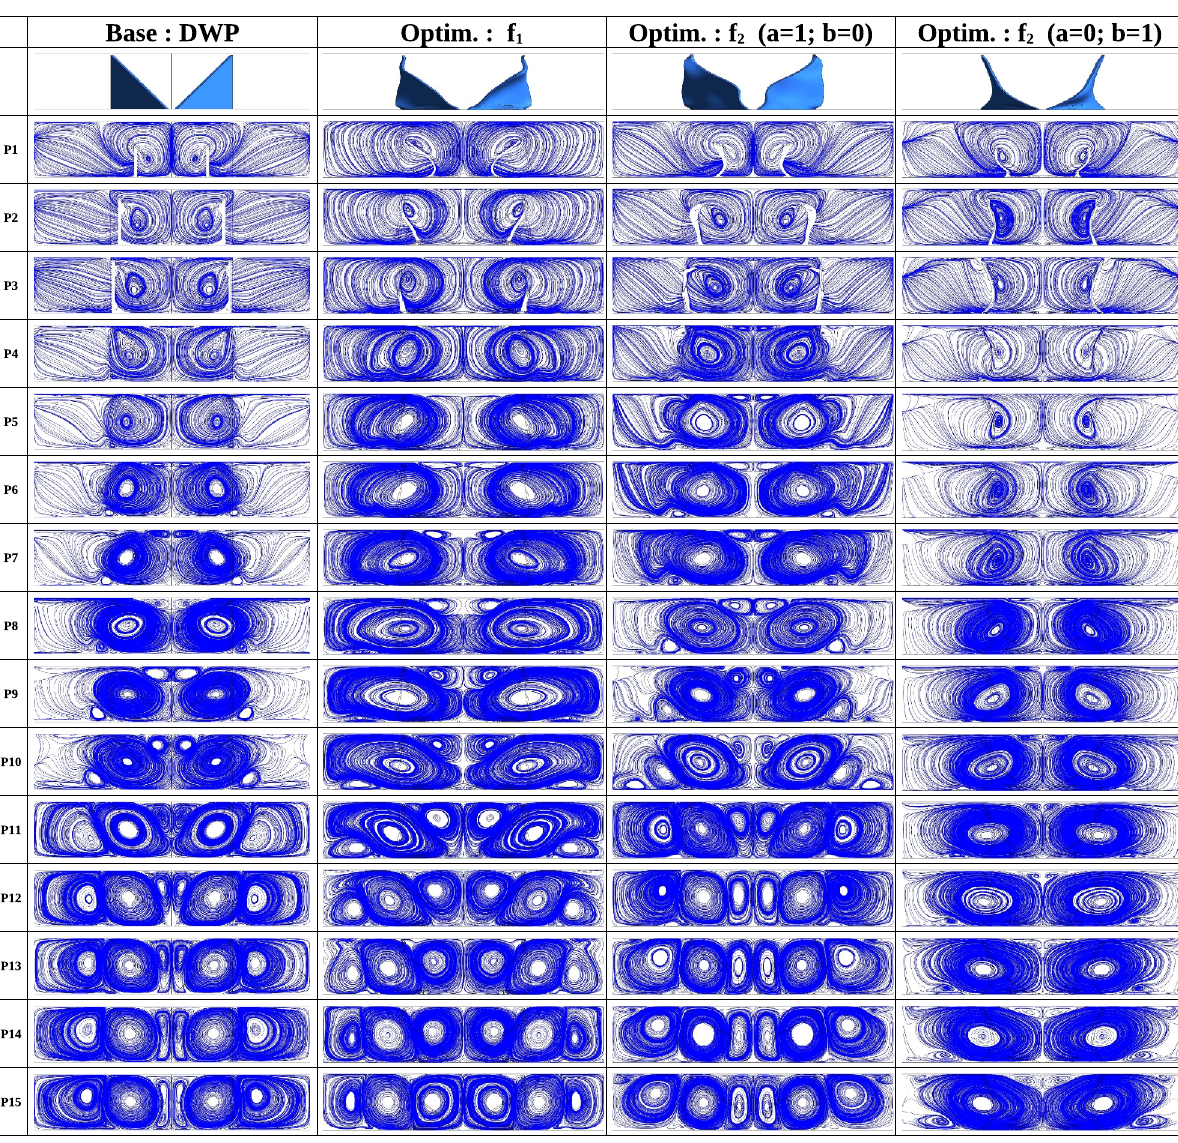
Figure 4. Streamwise velocity Streamlines at different z / L positions downstream the RVG for: Base DWP design, Optimum design using f 1 (Eqs. 4, 9), Optimum design using f 2 with a = 1 and b = 0 (Eq. 5) and Optimum design using f 2 with a = 0 and b = 1 (Eq. 5).